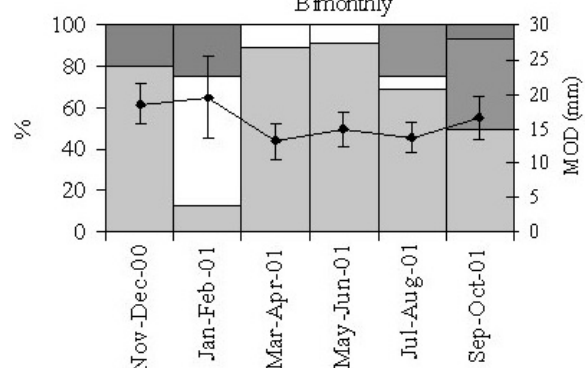
F IG . 6. – Bi-monthly evolution of maturity stages in adult females of T. marmorata ( (cid:3) mature; (cid:2) early pregnant; (cid:3) late pregnant; (cid:3) post-pregnant) and bi-monthly mean (± S.D.) maximum oocyte diameter (MOD) in adult females of T. marmorata .